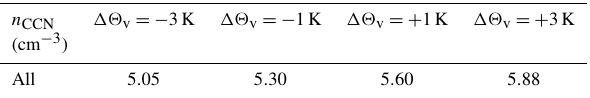
Table A5. Temperature sensitivity (in %K − 1 ) of total water vapour inflow I for all n CCN values.